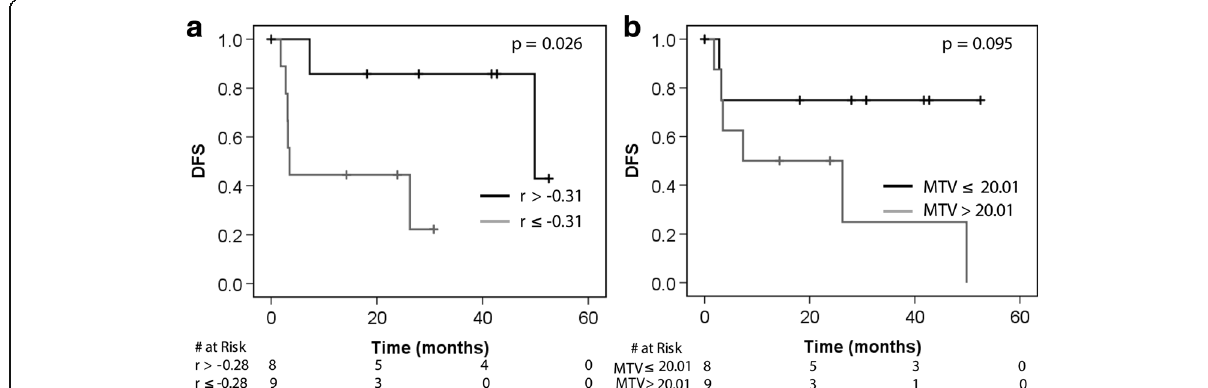
Fig. 4 Kaplan-Meier curves for DFS with patients stratified by the median Pearson ’ s r for the correlation between voxel ADC and SUV ( a ) and the median MTV ( b ). Tumors with a stronger inverse correlation between ADC and SUV show poorer disease